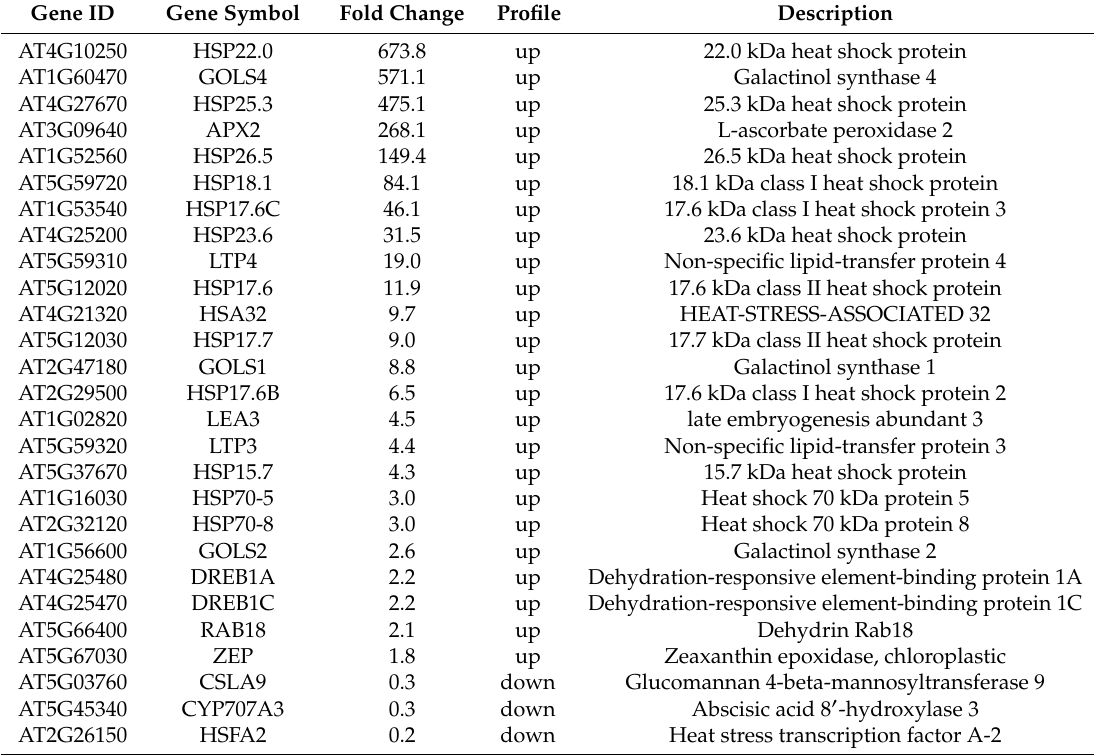
Table 1. The list of DEGs in TaHsfA6f transgenic Arabidopsis that are highlighted in this